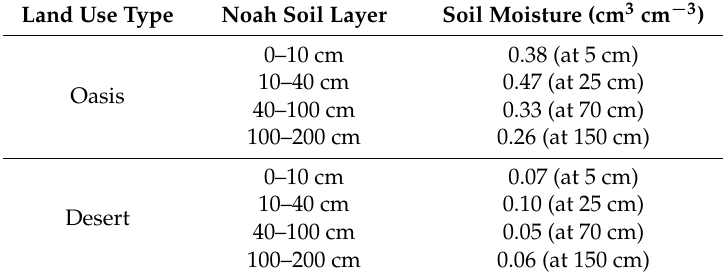
Table 2. Soil moisture values for the oasis and desert areas in the four Noah soil layers